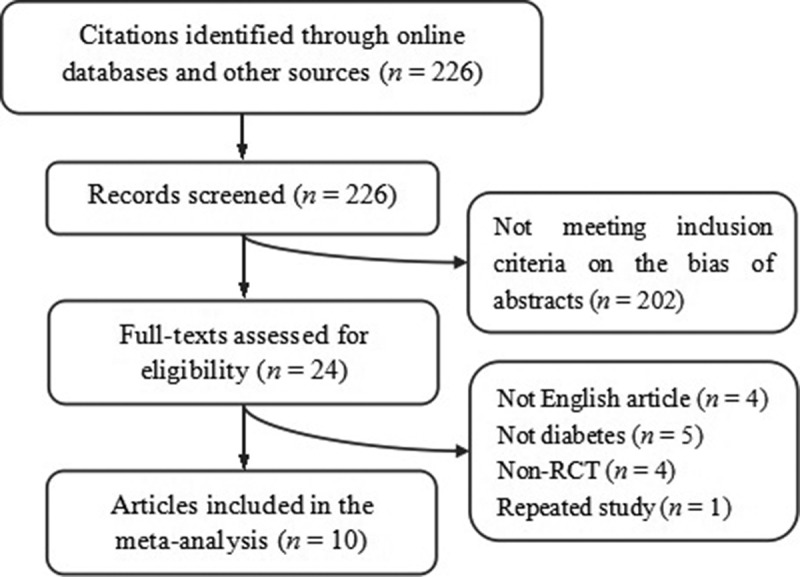
Trial inclusion.